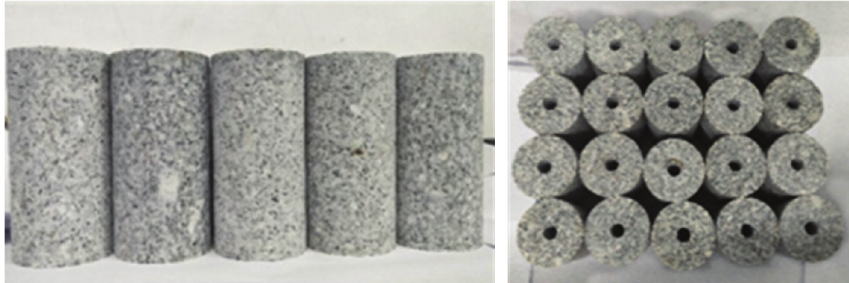
Figure 4: Granite specimen with a vertical hole.